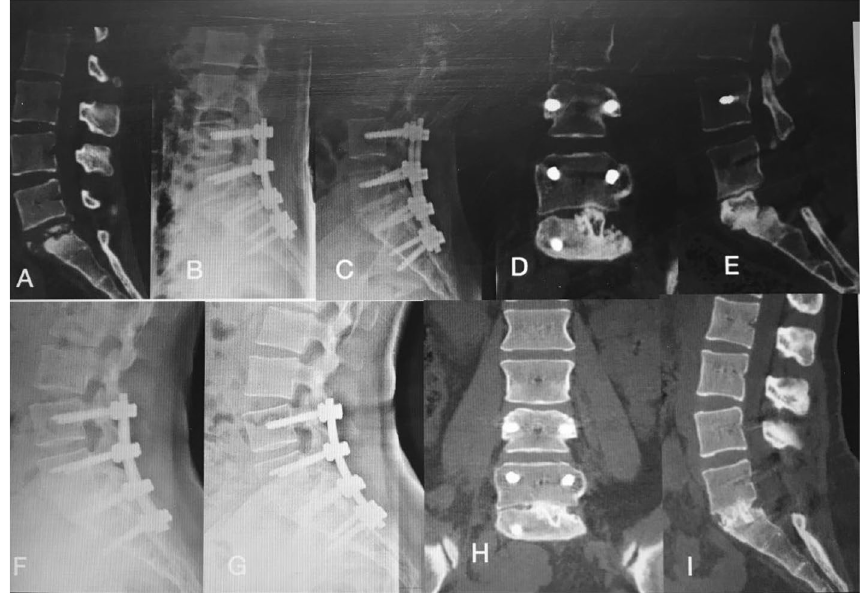
Figure 4. A 28-year-old female patient with lumbosacral spinal tuberculosis (L5-S1) underwent posterior debridement and decompression combined with instrumentation. ( A , B ) Preoperative computed tomography (CT) shows bone destruction of the L5-S1 vertebrae and compression of the nerve, and 1-week X-ray shows the correction was maintained. ( C – E ) The 6-month postoperative X-ray and 6-month postoperative CT show the correction was maintained, but the bone was not fully healed. ( F ) The 1-year and 2-year postoperative X-rays show the kyphosis correction has been maintained. ( G – I ) At 4-year follow-up, plain X-ray and CT show solid bone fusion.